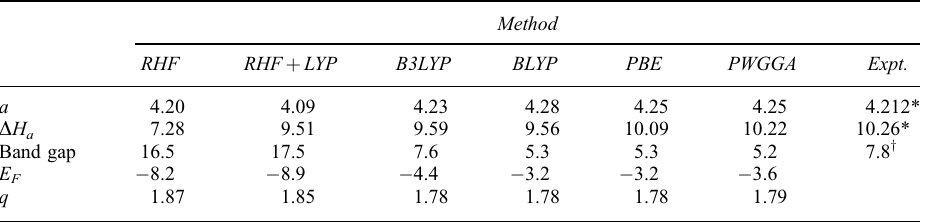
TABLE XII (a) Calculated Bulk Properties for MgO: Lattice Constant a (A˚ ), Heat of Atomization per MgO Unit D H a , Band Gap, Fermi Level E F (eV), and Mulliken Charges q